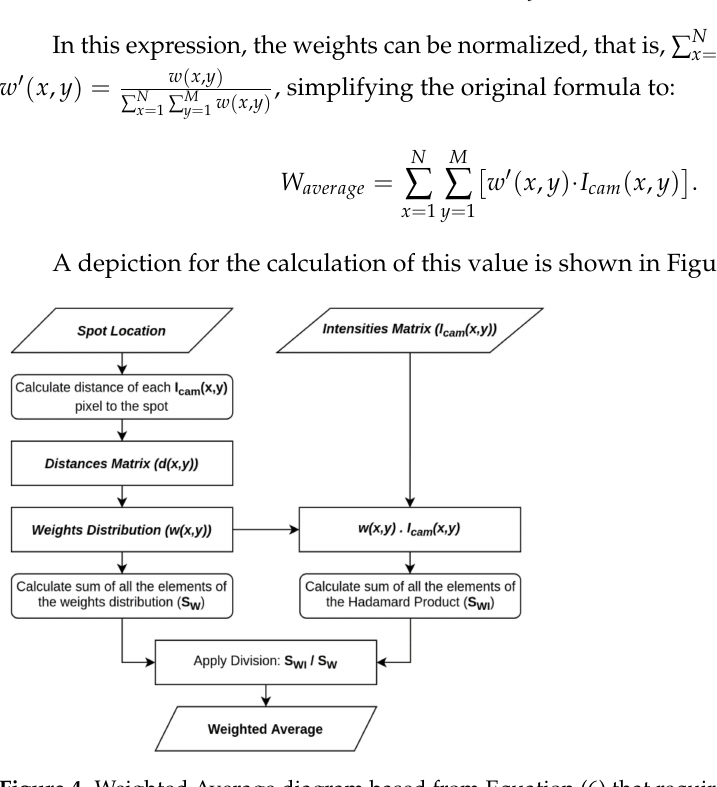
Figure 4. Weighted Average diagram based from Equation (6) that requires both the spot location in the camera, as pixel coordinates, and the captured intensities as inputs. For the calculation of the value of the weighted average, the weights distribution and captured intensity are required. The weights distribution is going to be of the size of the captured intensities, where first the distance of each pixel of the camera to the spot’s location in the image is calculated. Then, this result is updated in having values in the range of 0–100 where 0 corresponds to the pixels of the spot and 100 the most distant pixel(s) from it—weights distribution. Finally, by having the required variables for directly calculating the weighted average from Equation (6), the same is